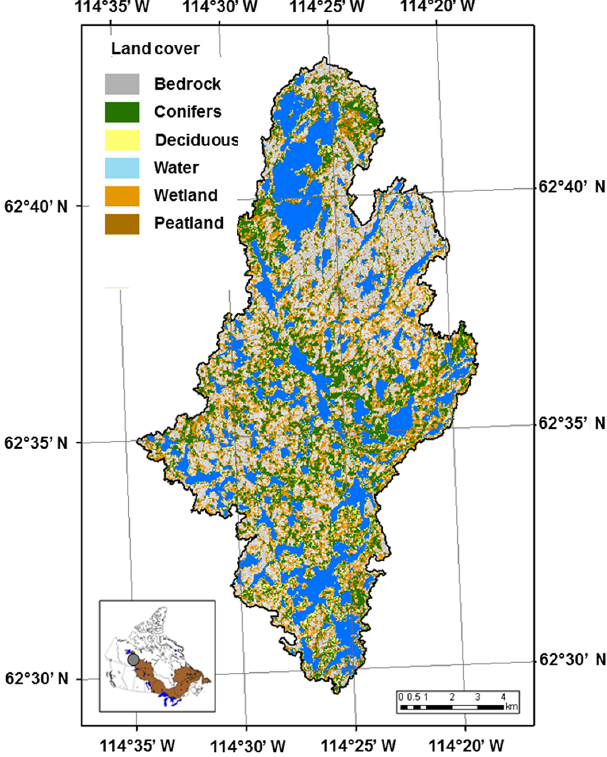
Figure 2. Baker Creek land cover derived from SPOT satellite im-